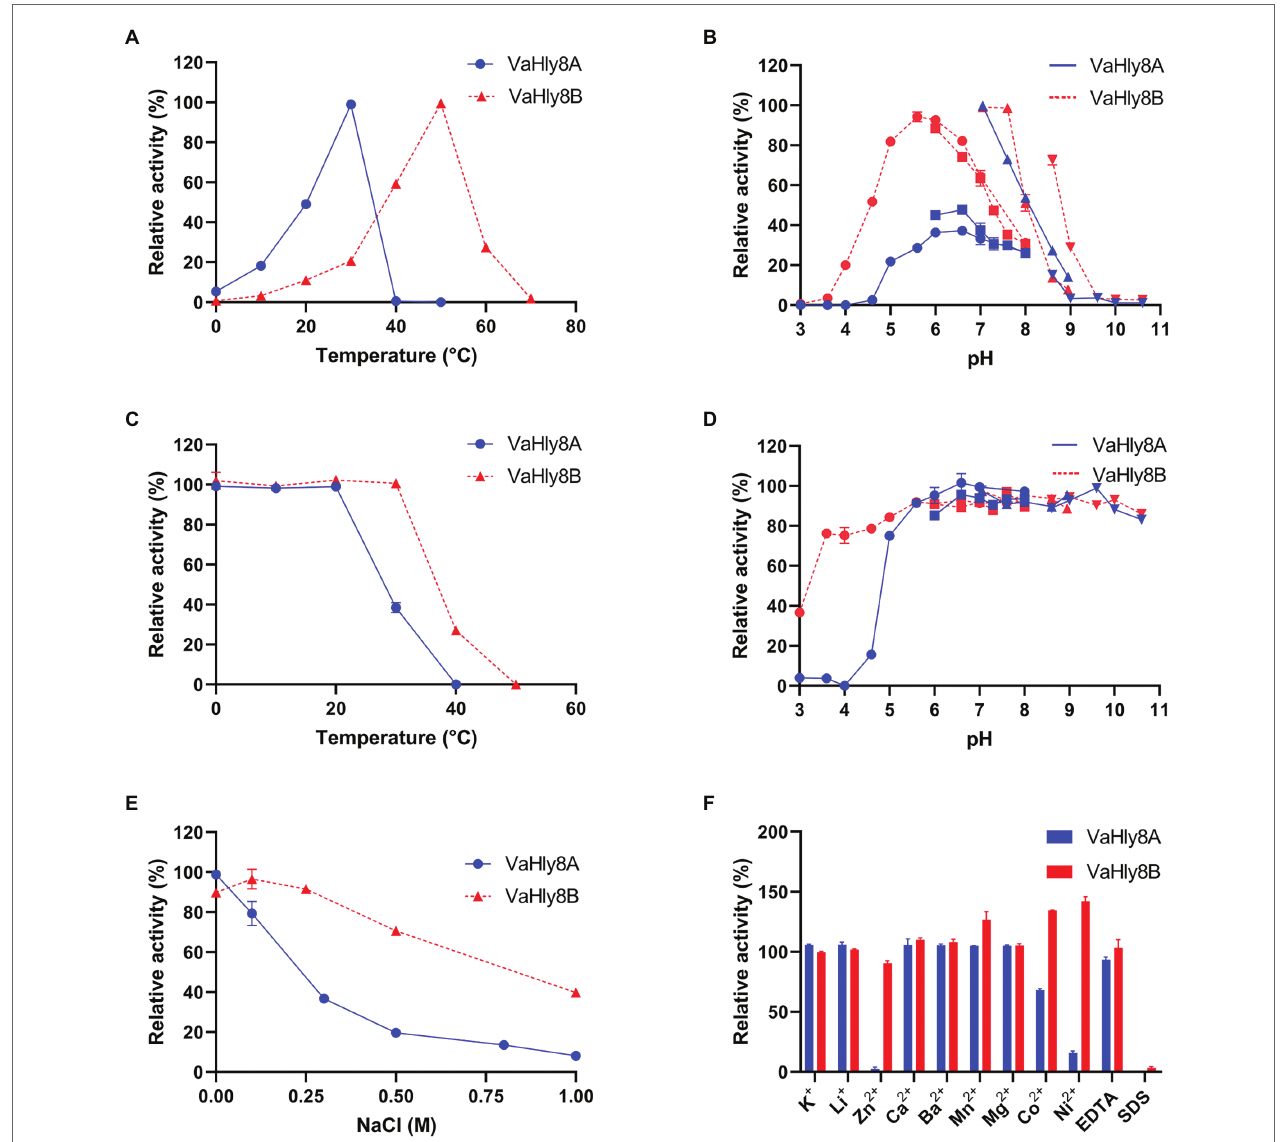
FIGURE 6 | Biochemical properties of the hyaluronate lyases VaHly8A and VaHly8B. (A) Effect of temperature. The enzyme activities of VaHly8A (1.69 μ g/ml) and VaHly8B (9.76 μ g/ml) were measured at 0–70 ° C. The highest specific activity of VaHly8A (106.70 U/mg) at 30 ° C and VaHly8B (17.57 U/mg) at 50 ° C were set as 100%. (B) Effect of pH. The enzyme activities of VaHly8A (1.13 μ g/ml) and VaHly8B (6.62 μ g/ml) were measured in 50 mM buffers, including Na 2 HPO 4 -Citrate buffer (pH 3.0–8.0; filled circles), NaH 2 PO 4 -Na 2 HPO 4 buffer (pH 6.0–8.0; filled squares), Tris-HCl buffer (pH 7.05–8.95; positive triangles), and Glycine-NaOH buffer (pH 8.6–10.6; inverted triangles). The highest specific activity of VaHly8A (223.65 U/mg) and VaHly8B (23.70 U/mg) in Tris-HCl buffer (pH 7.05) was set as 100%. (C) Thermostability of VaHly8A and VaHly8B. The enzymes were incubated for 1 h at different temperatures (0–50 ° C), and the residual activities were measured at 30 ° C for VaHly8A (5.83 μ g/ml) and 50 ° C for VaHly8B (55.50 μ g/ml). The initial specific activity of VaHly8A (223.65 U/mg) and VaHly8B (23.70 U/mg) were set as 100%. (D) The pH stability of VaHly8A and VaHly8B. The enzymes were incubated in above buffers (pH 3.0–10.60) for 6 h at 0 ° C, and the residual activities were measured at 30 ° C for VaHly8A (10.73 μ g/ml) and 50 ° C for VaHly8B (61.75 μ g/ml). The initial specific activity of VaHly8A (223.65 U/mg) and VaHly8B (23.70 U/mg) were set as 100%. (E) Effect of NaCl. The enzyme activities were measured in Tris-HCl buffer (pH 7.05) containing different concentrations of NaCl ranging from 0 to 1.0 M at 30 ° C for VaHly8A (0.67 μ g/ml) and 50 ° C for VaHly8B (4.39 μ g/ml). The highest specific activity of VaHly8A (223.65 U/mg) without NaCl and VaHly8B (26.38 U/mg) in the presence of 0.1 M NaCl were set as 100%. (F) Effects of various compounds. The enzyme activities were measured in Tris-HCl buffer (pH 7.05) containing 1 mM various compounds at 30 ° C for VaHly8A (1.06 μ g/ml) and 50 ° C for VaHly8B (3.60 μ g/ml). The specific activity of VaHly8A (223.65 U/mg) and VaHly8B (26.38 U/mg) without tested compounds was set as 100%. Values represent the mean of three replicates ±